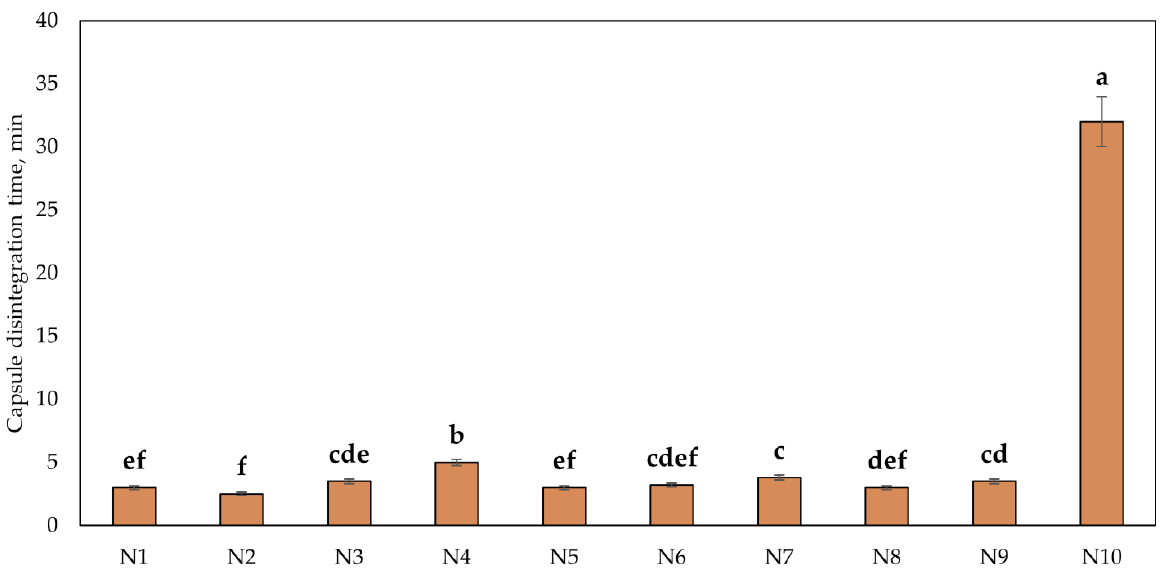
Figure 4. Results of the capsule disintegration test. Different letters indicate significant differences ( p < 0.05) between the tested capsule formulations, and capsule formulations with same letter were not significantly different ( p > 0.05). The compositions of the capsules (N1–N10) are described in